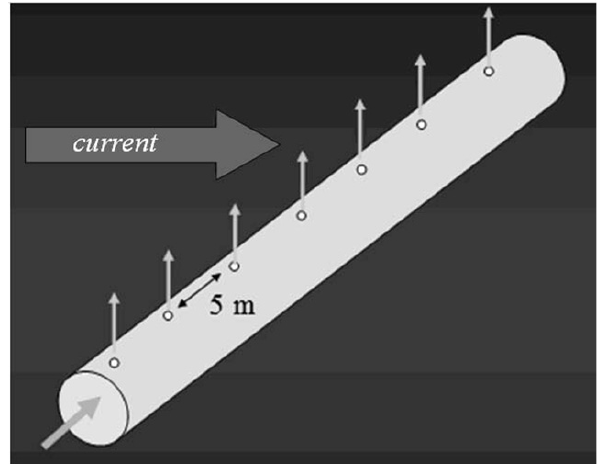
Fig. 1. Schematic description of the multiport ocean outfall (the cur- rent direction being parallel to the mean shoreline and perpendicular to the diffuser; the discharge jets from circular ports are vertical)